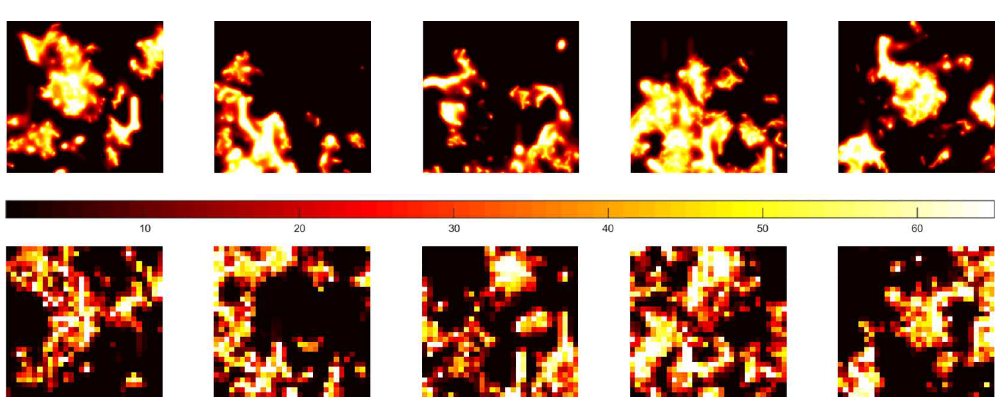
Fig 6. Sample slices. A 100 μ m thick centre slice of samples 1 (left) through 5 (right) from the CTM (upper row) andITM (lower row) computations. The image width and height is 3 mm each and the colour bar illustrates the pO 2 scale in mmHg.